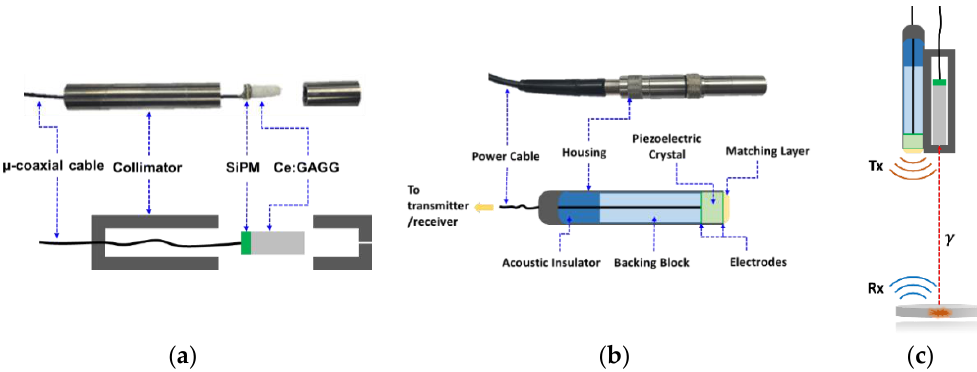
Figure 2. ( a ) Photograph and schematic of the nuclear medicine (NM) gamma probe and its components. ( b ) Commercial V311-SU 10 MHz transducer from Olympus Corp. used for US signal transmission and reception. ( c ) Illustration of the hybrid US-gamma probe.